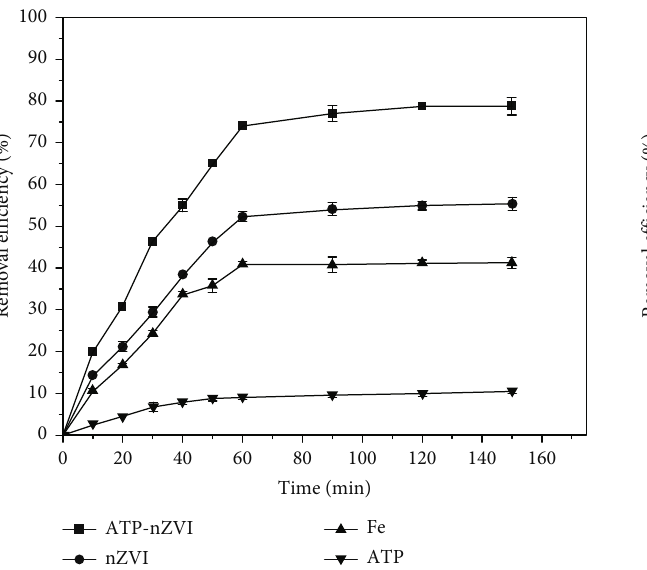
Figure 6: E ff ect of changes in initial pH on NO -N concentration = 30 mg/L, adsorbent = 1 : 5 g/L, (initial NO 3 reaction temperature = 25 ° C, and contact time = 150